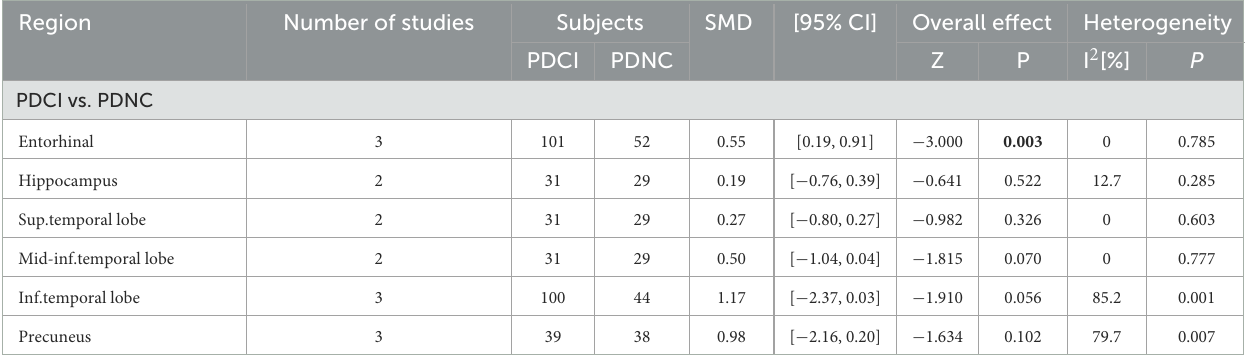
TABLE 5 Random effects meta-analyses results between PDCI and PDNC subjects. Region Number of studies